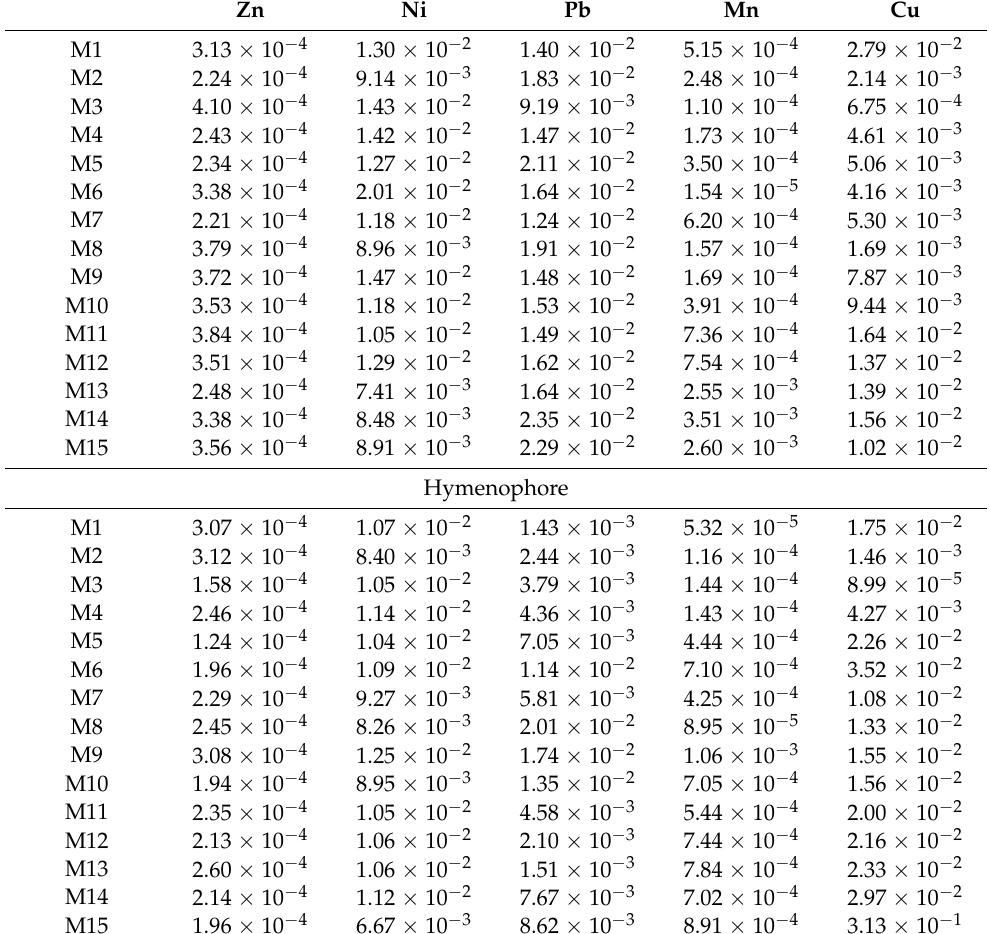
Table 6. The potential human health risk (HRI) of heavy metals through consumption of M. galilaea (FB and